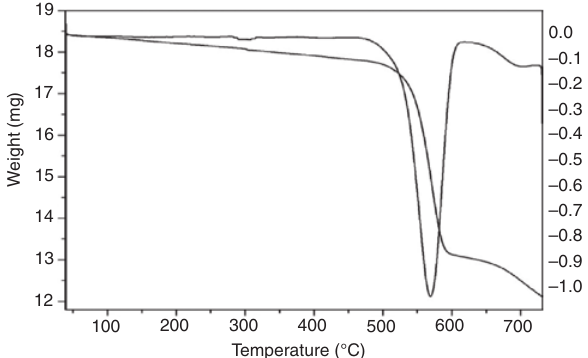
Figure 8: TG/DTG curve of PDTP.